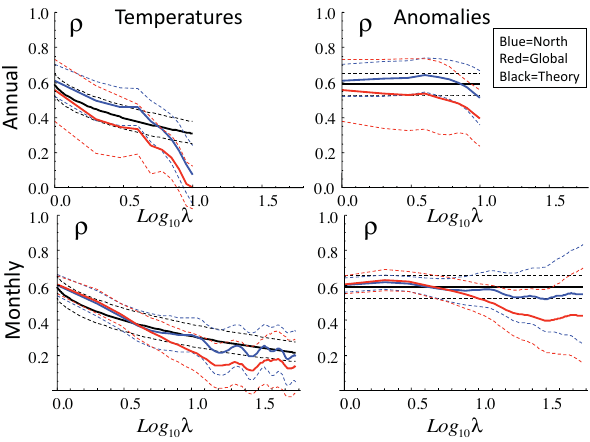
Figure 9. The empirical correlations of the forecast temperatures (left column) and anomalies (right column). The same hindcasts but with different empirical comparisons and also with comparisons with theory for H =− 0.2 (thick black line), H =− 0.17 (top dashed black line), and − 0.23 (bottom dashed black line). Now note that in all cases the one standard deviation bounds (dashed) on the empir- ical and theoretical curves overlap virtually throughout. The theory curves have no adjustable